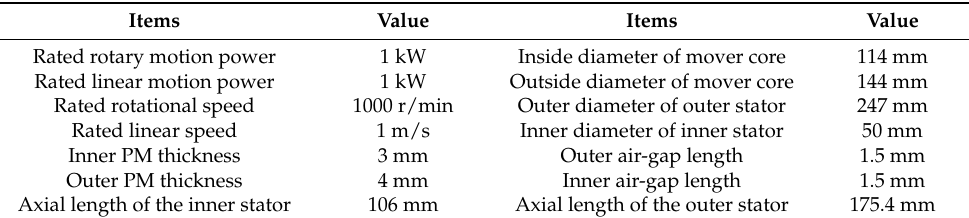
Figure 10. 3D FE model and its mesh. The calculated radial flux density waveforms compared with the FEM results are shown in Figure 11. It is clear that the analytical calculated radial airgap flux densities considering the orthogonal effect (OE) are agreed well with that obtained by the 3D FE analysis. Figure 12 shows the tangential flux density waveforms, the analytical results also coincide with the 3D FEM analysis. The calculated tangential flux densities are consistent with the results of the FE analysis very well both of the rotary and linear motion unit. The analytical flux densities without considering the orthogonal effect are all bigger than that of considering the OE in the rotary and linear motion unit. It can also be noted that the model without considering the orthogonal effect get 2.5% and 8.8% error rates when calculate the flux density of the rotary and linear motion unit respectively.